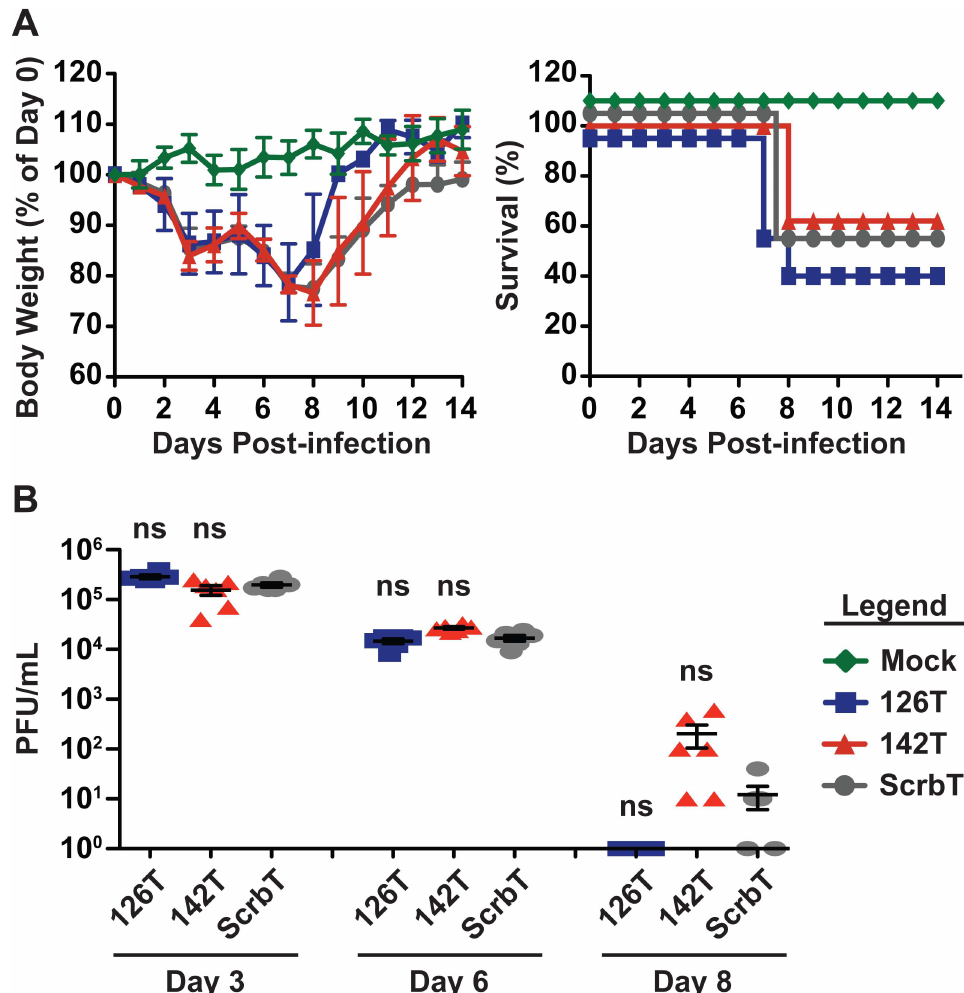
Fig 7. Restriction of low pathogenic H5N1 replication in endothelial cells does not alter disease outcome in mice. (A) Body weight loss and survival of infected mice. C57BL/6Jmice (n = 5) were intranasally infected with 100 PFU of tropism restricted low pathogenic H5N1 viruses and monitored daily for body weight and survival. Left—Body weight loss, shownas relative percentage of day 0 weight (mean ± SEM) and Right– Survival. For better display, survival lines are offset by a few percentagepoints. (B) Viral titers in the lungs of infected mice. C57BL/6Jmice (n = 5–6) were infected with 100 PFU and viral loads in the lungs on days 3, 6, and 8 pi were determinedby plaqueassay (PFU/mL). Each data point represents an individual mouse (mean ± SEM). Asterisk denotesstatistical significancedetermined by one-wayANOVA in comparison to the H5N1-ScrbTgroup and the values are denotedas * p < 0.05, ** p < 0.01, *** p < 0.001 and ns–non significant. Data presentedhere is a representativeof two independent experiments.